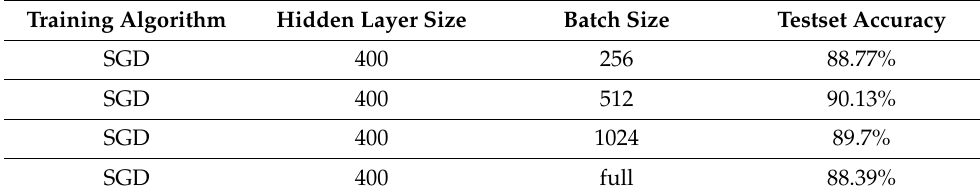
Table 4. Testset accuracies on different batch sizes.